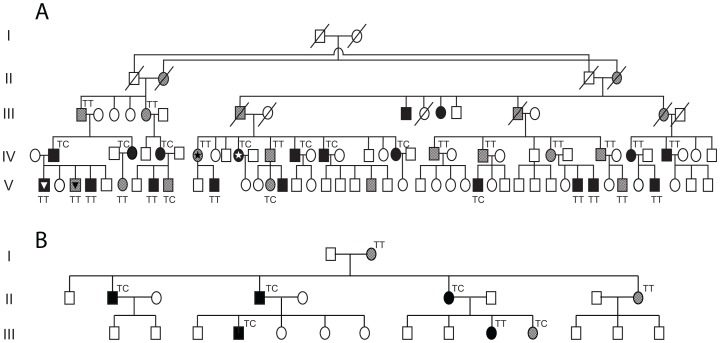
Analysis of rs4806718 alleles in two unrelated pedigrees.(A) Family RP856/AD5. The individuals initially tested with NGS are marked with a star. The individuals marked with a triangle belong to a sibship pair, which was previously shown by McGee et al. to have the same isoallele haplotype but different phenotypes. (B) Family ADB1, a Bulgarian gypsy family carrying a heterozygous splice site mutation in PRPF31 (NM_015629.3:c.527+1G>T, or IVS6+1G>T). In both pedigrees carriers of mutations are either in black (affected individuals) or in grey (asymptomatic individuals).